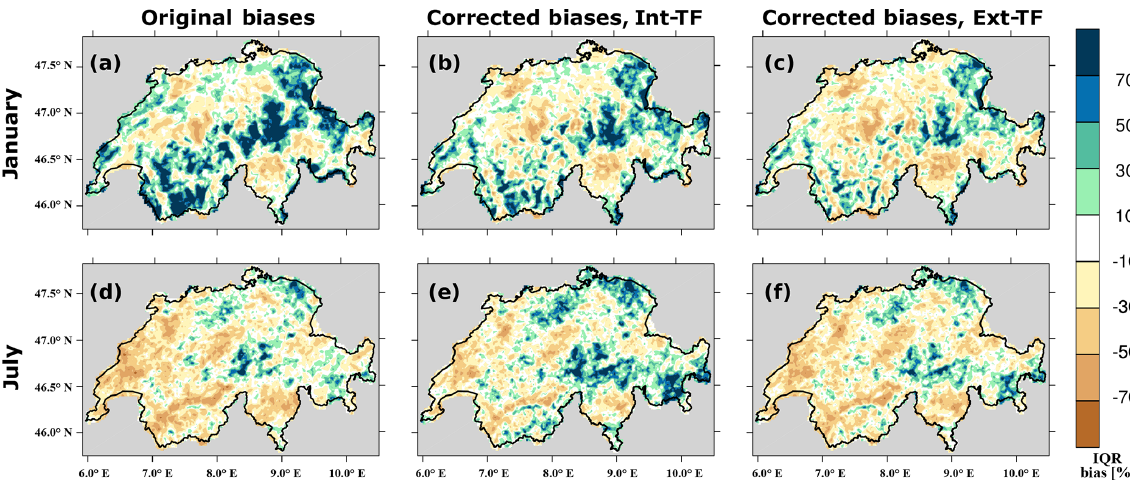
Figure 8. Biases in the interquartile range of monthly mean precipitation intensity over Switzerland. Panel (a) represents the original biases in January, (b) the biases after being corrected using Int-TFs in January, and (c) the biases after being corrected using Ext-TFs in January; panels (d) , (e) , and (f) are the same as (a) , (b) , and (c) but in July,